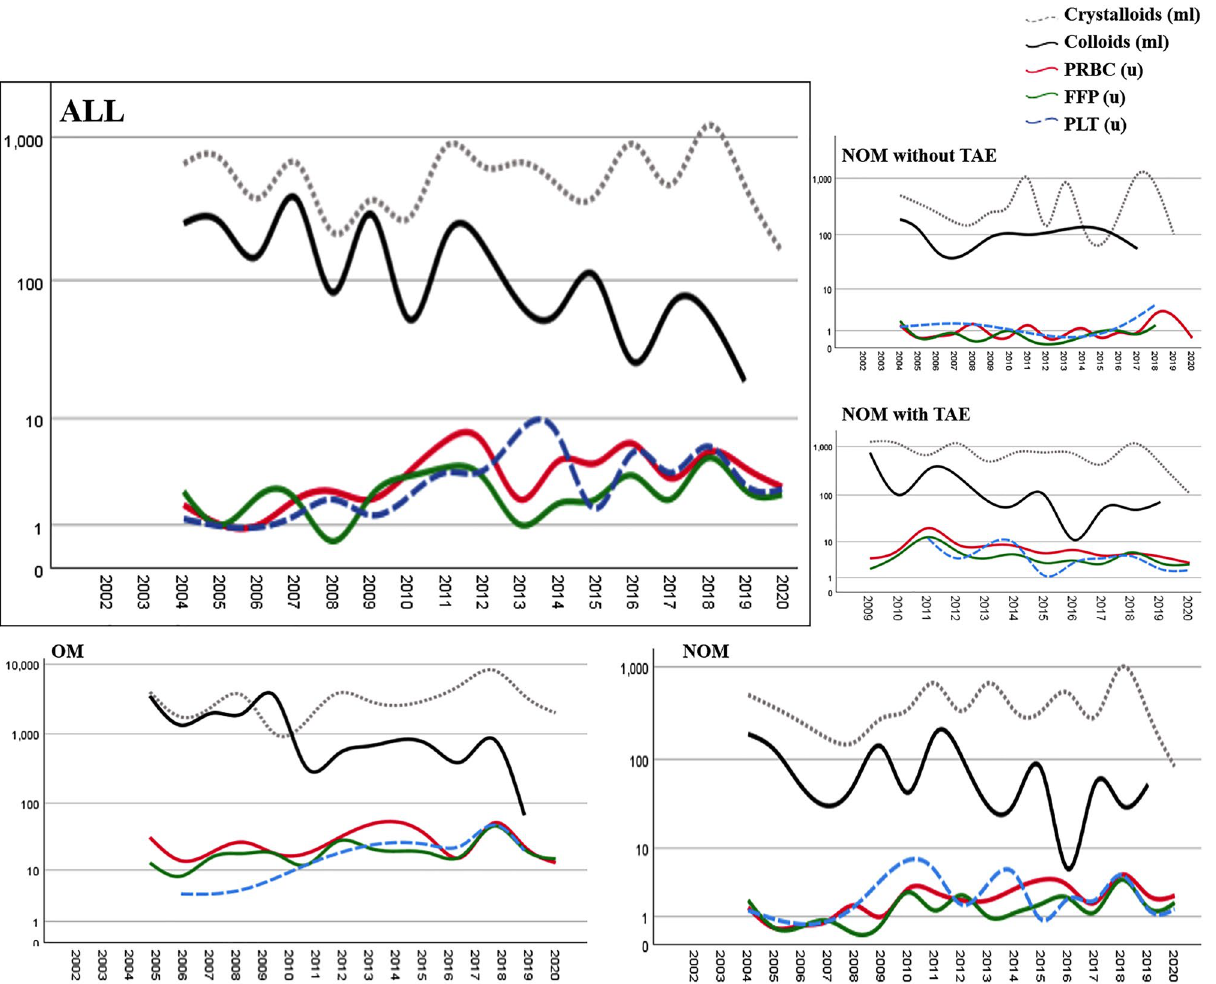
Figure 3. Chronological changes in transfusion amount. Median of resuscitation volume over time. Resuscitation volumes are further stratified by managements. All patients (left upper). NOM without TAE group (right upper). NOM with TAE (right middle). OM (left lower). NOM (right